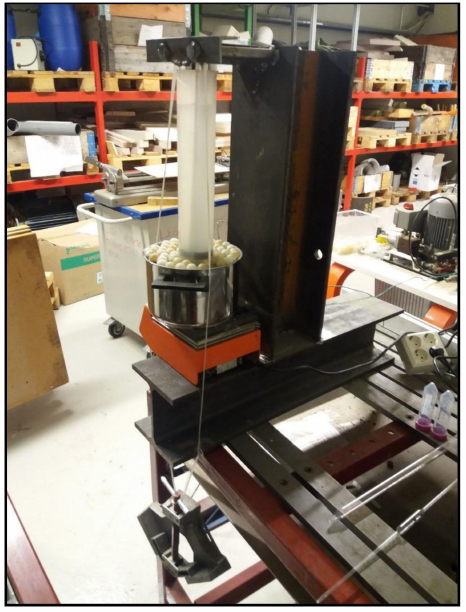
Figure 3. The glass fibre stress corrosion experimental